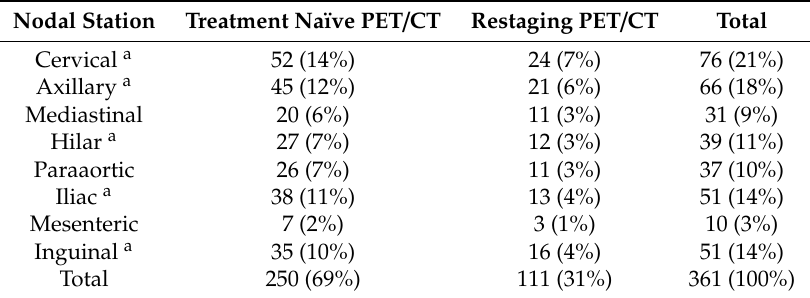
Table 3. Number of FDG PET / CT cases showing involvement by nodal